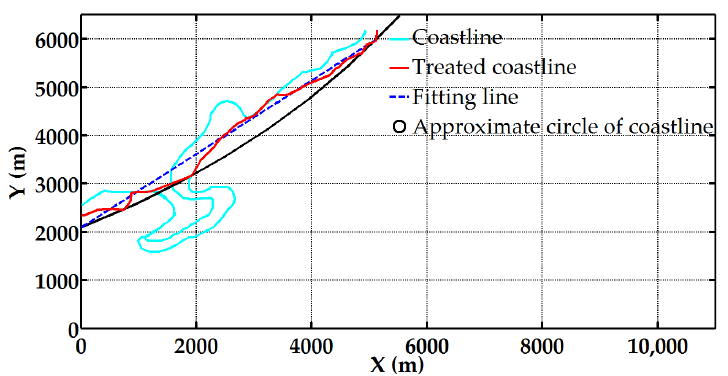
Figure 10. The coastline model after